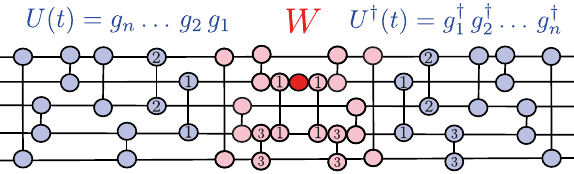
Fig. 4 Illustrationoftheswitchbackeffect.Theperturbation W isacted onby U ( t ) ontheleftand U † ( t ) ontherighttocreatetheprecursoroper- ator. Two qubit gates participating in the most efficient preparation of U ( t ) are labeled g i and they appear as light-purple circles before apply- ing them to W (and as light-red circles after being applied). Estimating the complexity of the precursor operator at different times depend on delicate cancellations which can be seen after applying the gates. For example, the gate g 2 commutes with the perturbation and the previously applied gates and therefore does not contribute to the complexity